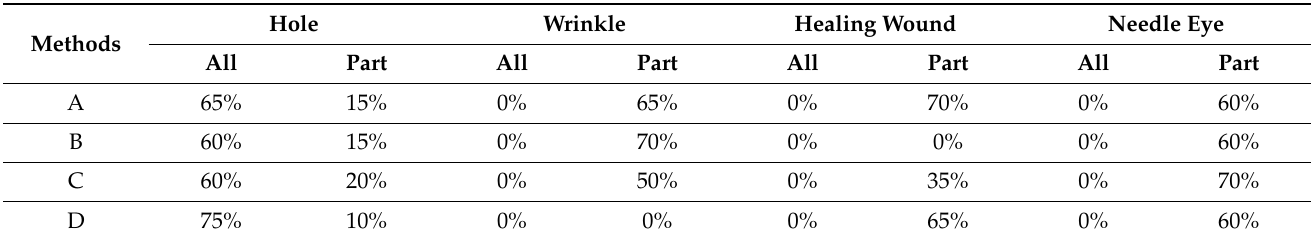
Table 1. The detected results by using edge